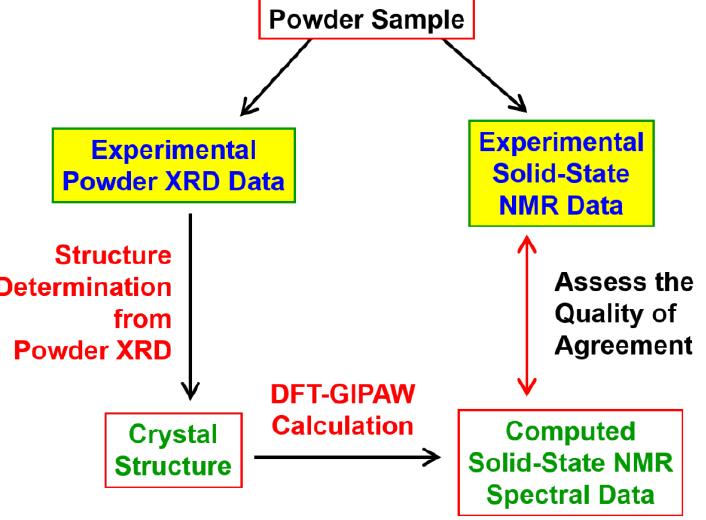
Figure 2. Schematic overview of the strategy to exploit solid-state NMR data in the validation of a crystal structure determined from powder XRD data.